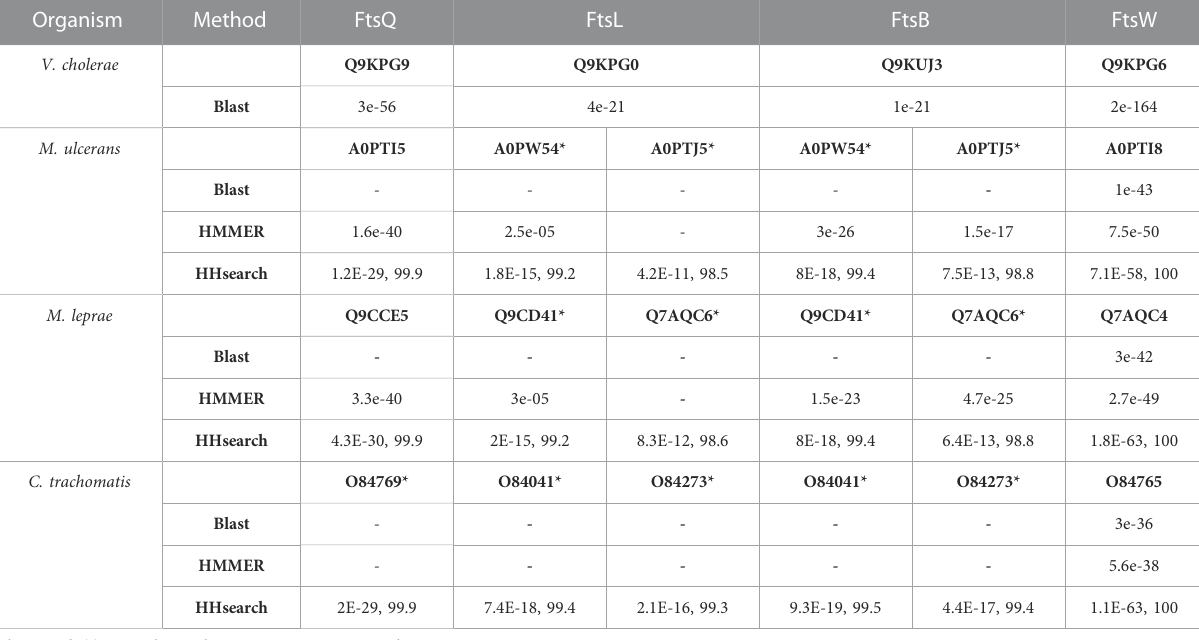
TABLE 1 Results for FtsQ, FtsB, FtsL, and FtsW remote homologs mapped on target genomes. For BLAST and HMMER, only e-values are listed against the proteins. For HHsearch, both e-values and probability scores are listed.